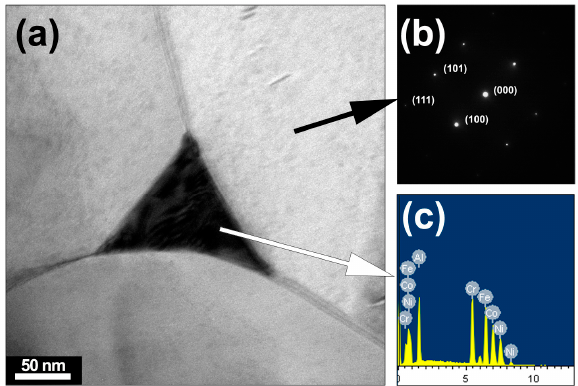
Figure 6. ( a ) TEM images of a bright place selected from the TiB 2 -5 wt. % HEA composites sintered at 1650 °C; ( b ) corresponding SAED of grain phase; ( c ) corresponding EDS patterns of liquid phase.